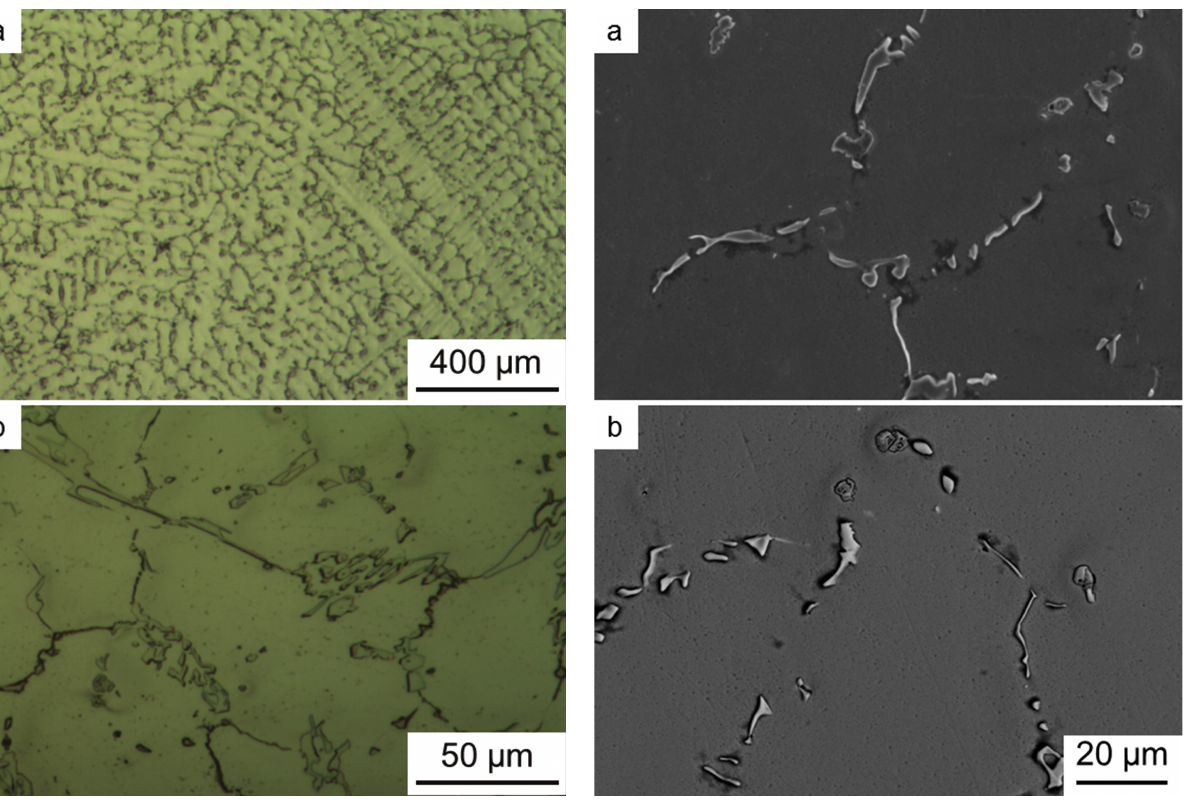
Figure 1: Light optical micrographs of the as-cast alloy at two magnifications.